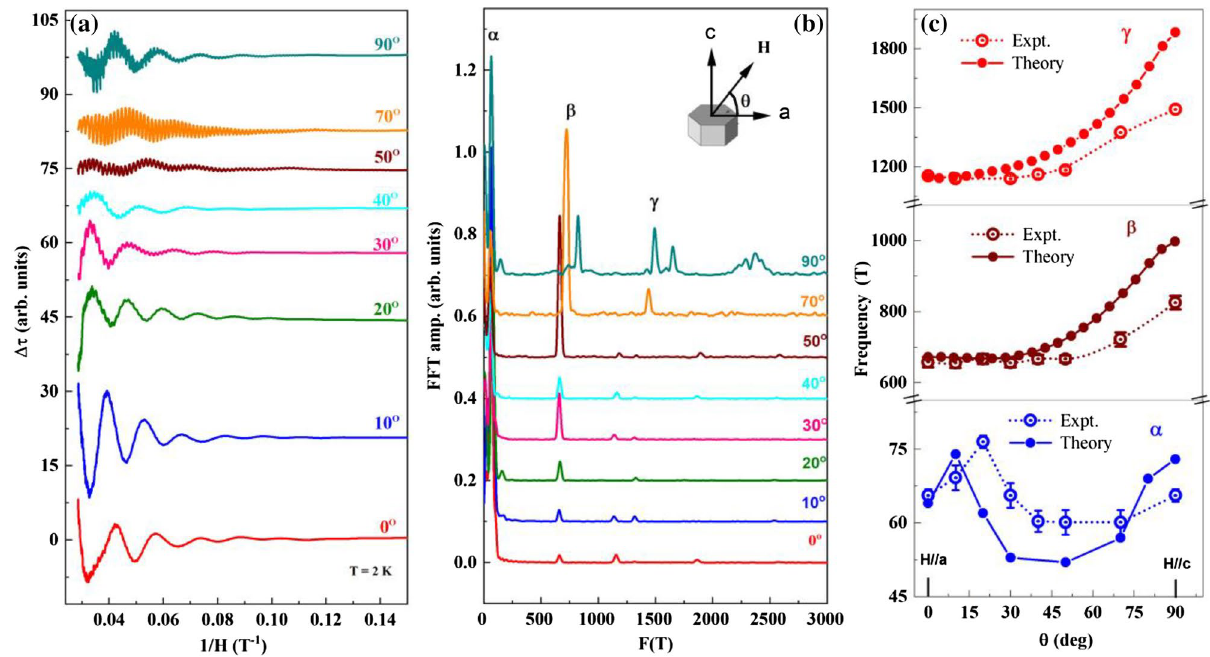
Figure 4. Angle dependence dHvA oscillations in PdTe. ( a ) Magnetic torque of PdTe at T = 2 K after background subtraction plotted as Δτ ( H ) versus H -1 at indicated angles. A constant offset is added to the data for clarity. ( b ) The FFT spectra of the dHvA oscillations in ( a ). ( c ) The angle dependence of F α , F β and F γ from both experiment and calculations. The error bars are taken as the half-width at the half height of the FFT